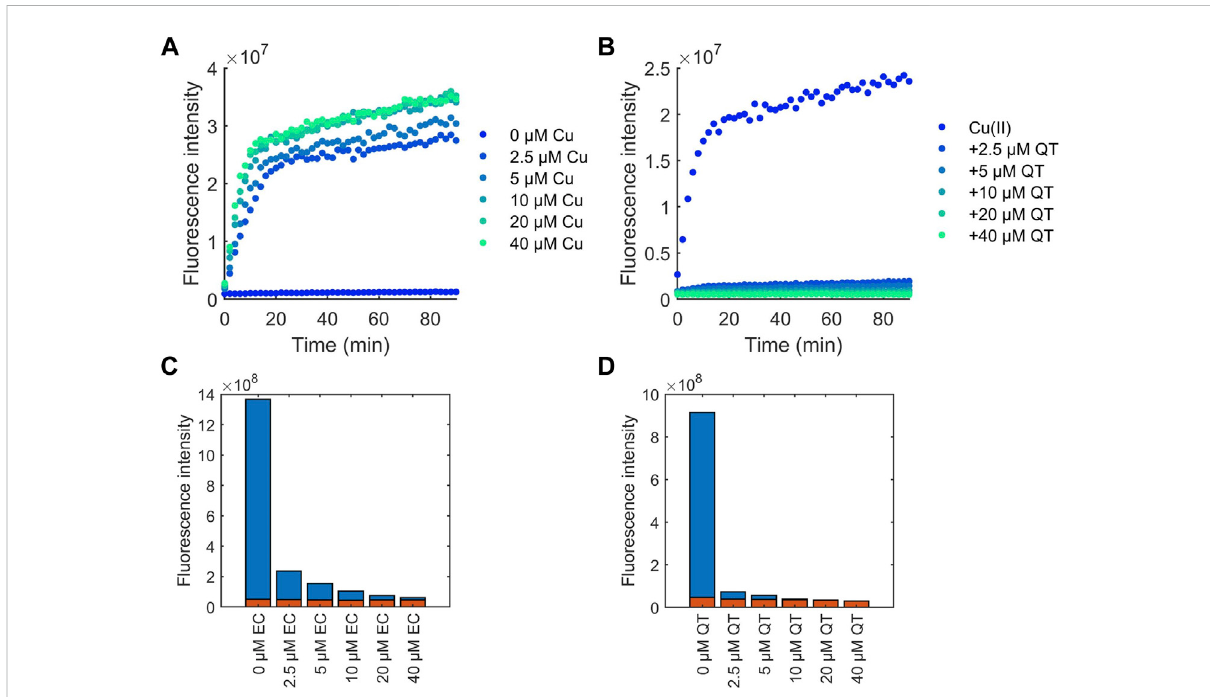
FIGURE 7 CCA fl uorescence intensity measurements for determining the effects of fl avonoids on the time-dependent generation of effects were compared to (A) Cu(II) addition alone, with (B) QT shown as an example. 2.5 mM CCA and 50 μ M ascorbic acid were used for all experiments. The calculated area under the curve over the course of 90 min was measured for fl avonoid solutions. (C) EC and (D) QT effects are shown as representative plots in the presence (blue) and absence (red) of